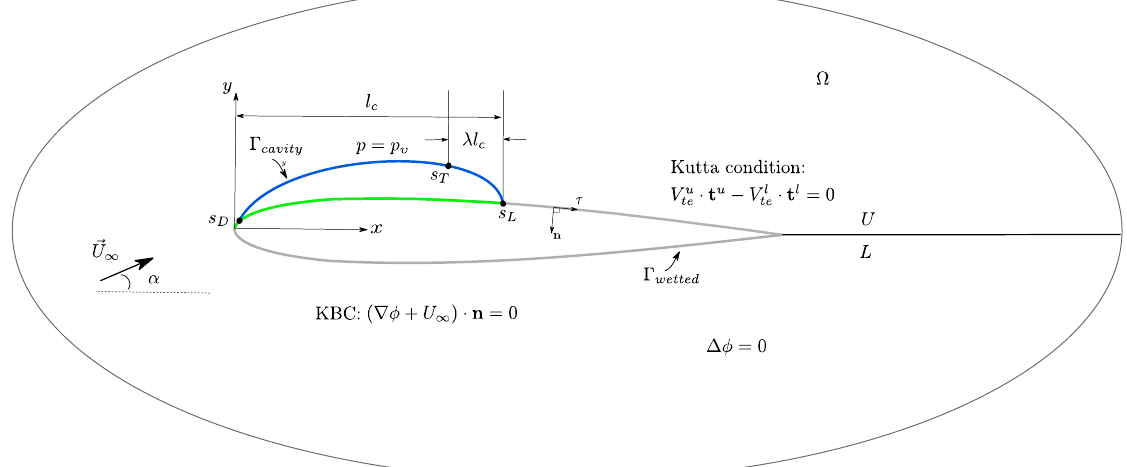
Figure 1. Schematic presentation of the partially cavitating hydrofoil problem in steady inflow.